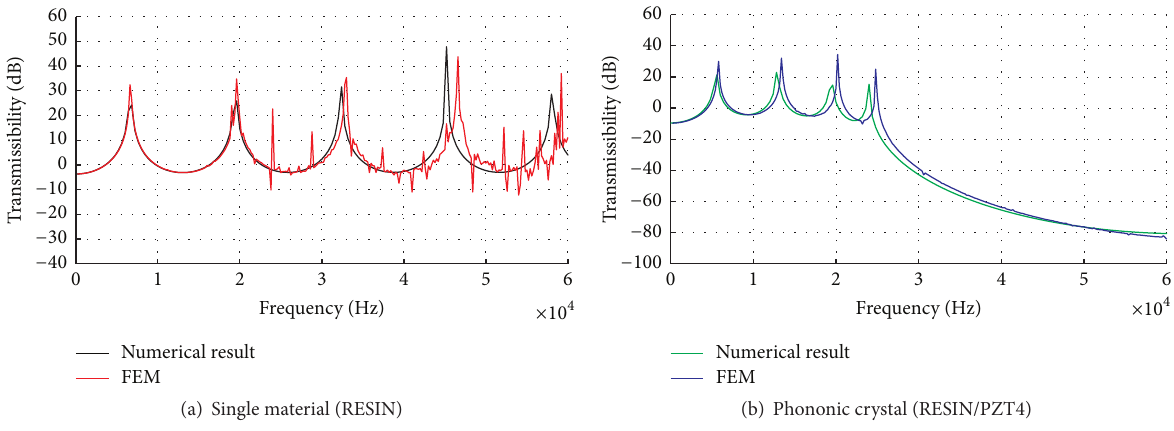
Figure 4: Radial vibration curves of numerical and FEM